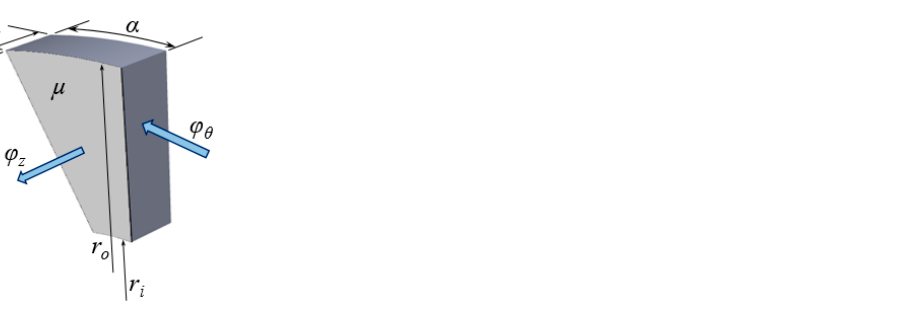
Figure 4. Geometry of a typical reluctance element. φ z : axial flux; φ θ : circumferential flux.